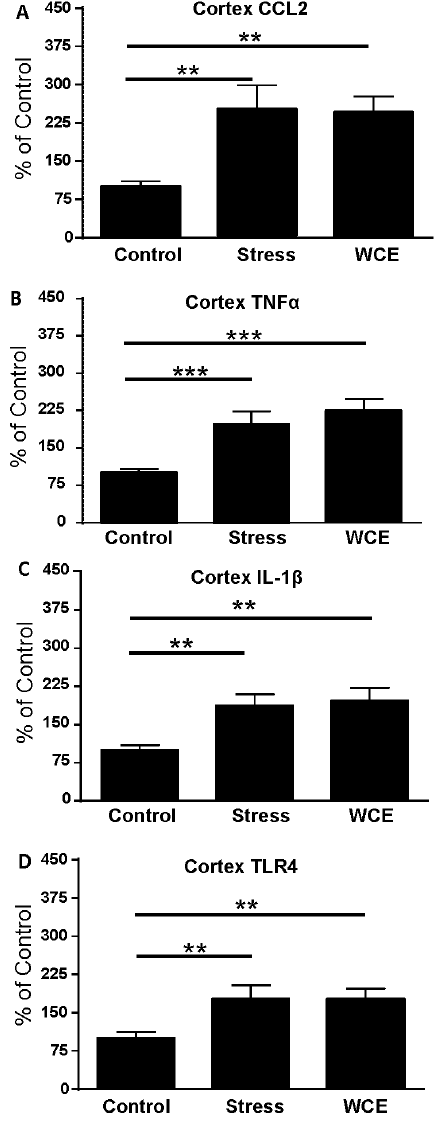
Figure 3. Effects of restraint stress or withdrawal from chronic ethanol (WCE) on cerebro-cortical neuroimmune mRNAs. Control and stress rats received non-ethanol containing liquid diets and 1 h restraint stress or no stress, respectively. WCE rats received chronic ethanol liquid diet for 15 days